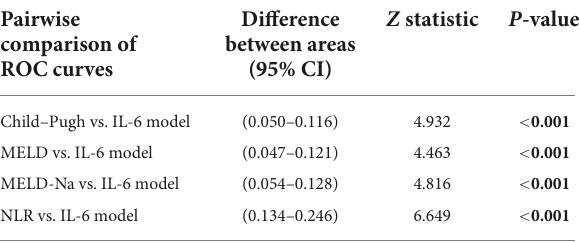
TABLE 5 IL-6 model versus other models for prediction 28-day